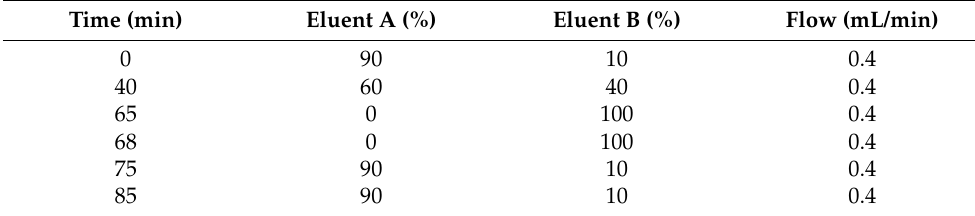
Table 4. Flow gradient